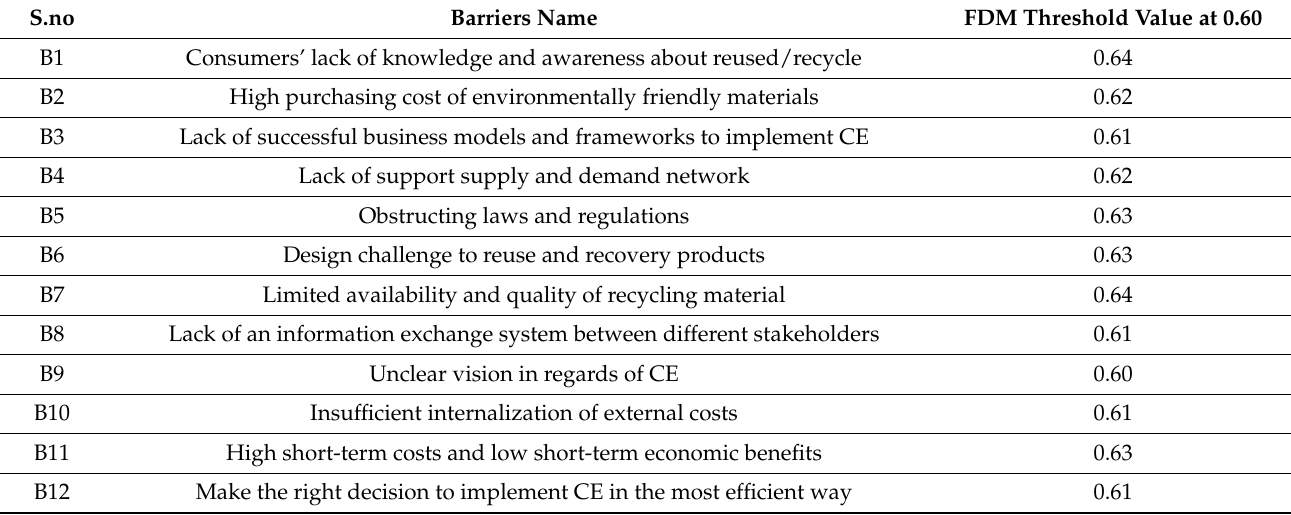
Table 3. The selected key barriers based on Fuzzy Delphi Method